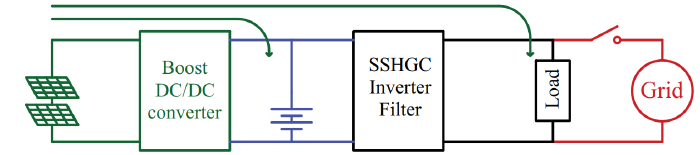
Figure 4. Power operation mode 1.